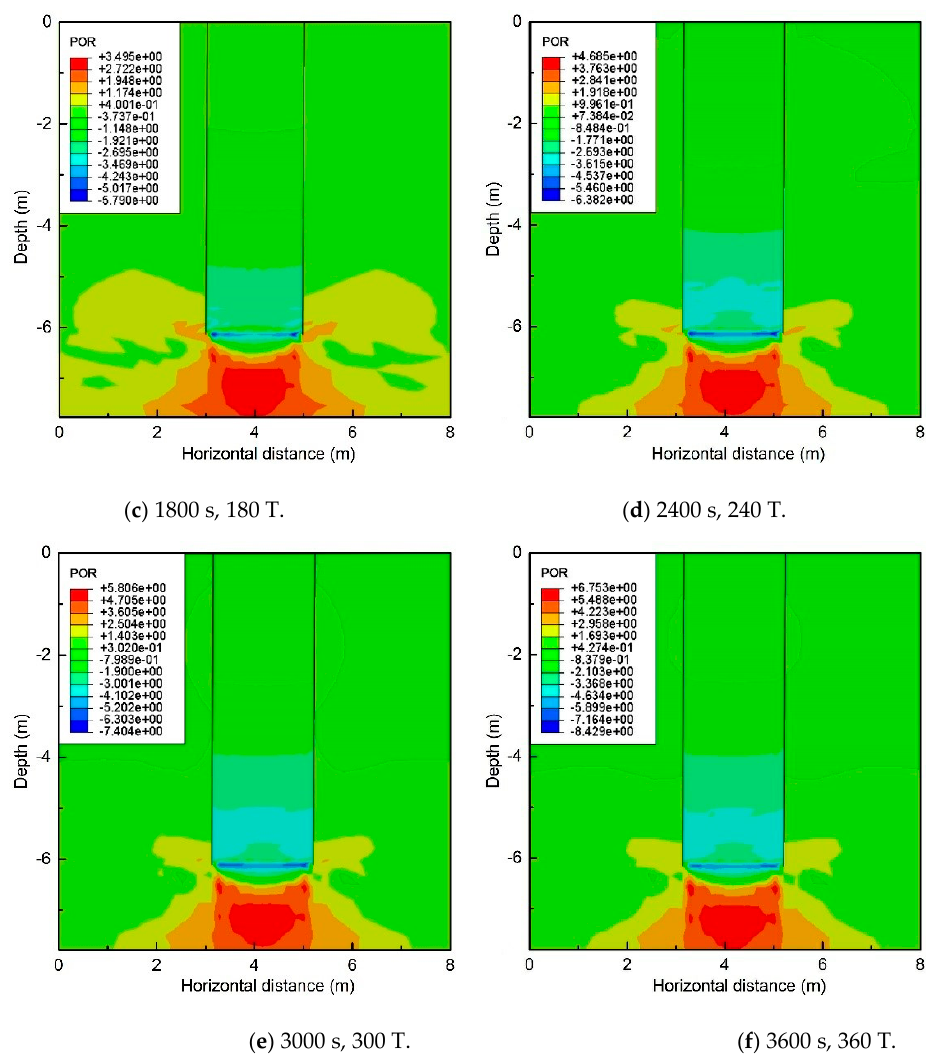
Figure 9. Distribution of the residual pore pressure in the soil around a suction anchor at different